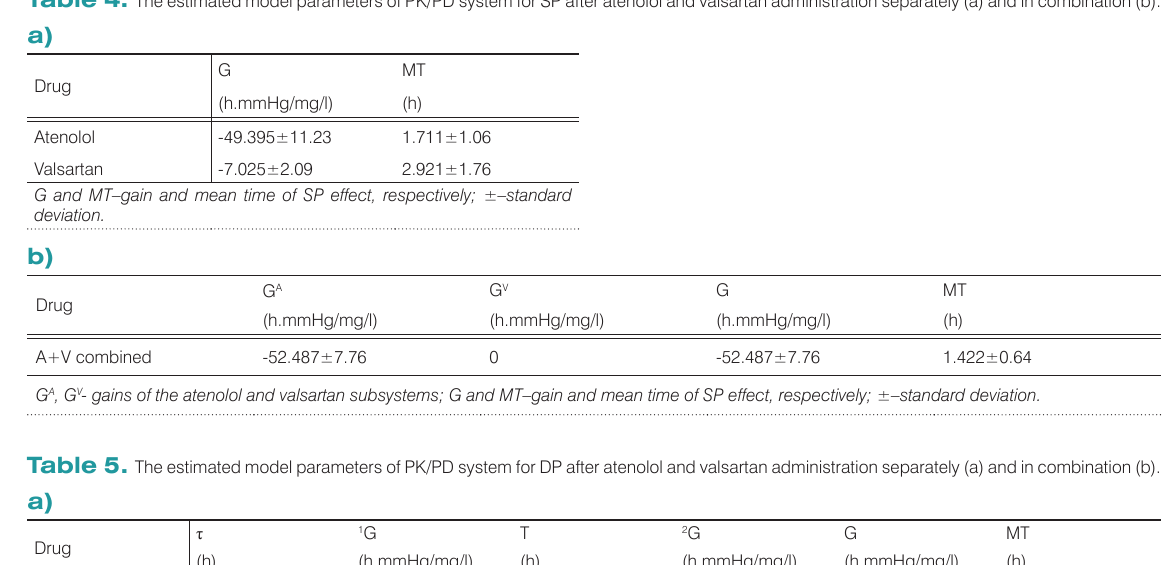
Table 4. The estimated model parameters of PK/PD system for SP after atenolol and valsartan administration separately (a) and in combination (b).